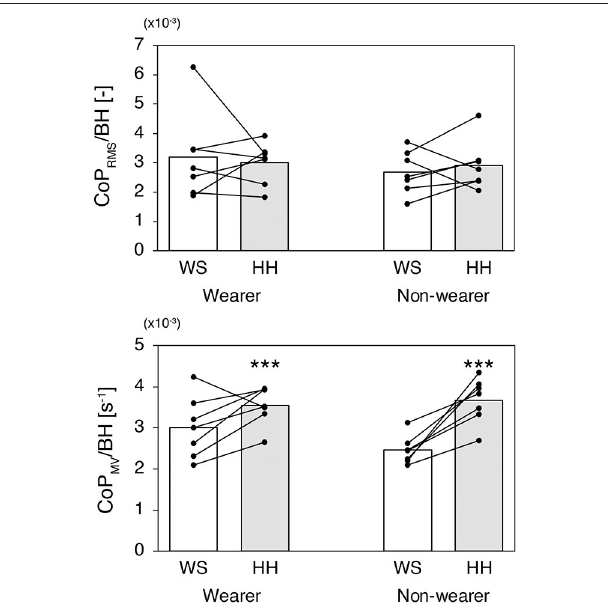
FIGURE 3 | The CoP RMS ( top ) and CoP MV ( bottom ) for each group and each test condition. The white bar indicates the WS condition and the gray bar indicates the HH condition. The small dots represent data for individual participants. *** P < 0.001 between the test